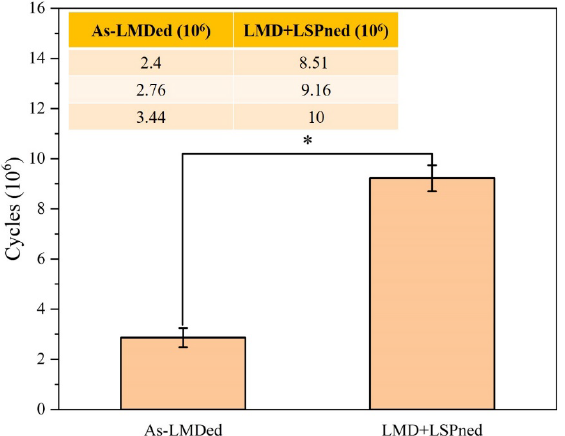
Figure 11. The vibration fatigue cycles of as-LMD and LMD+LSPned samples. (* p < 0.05 compared to the as-LMD).